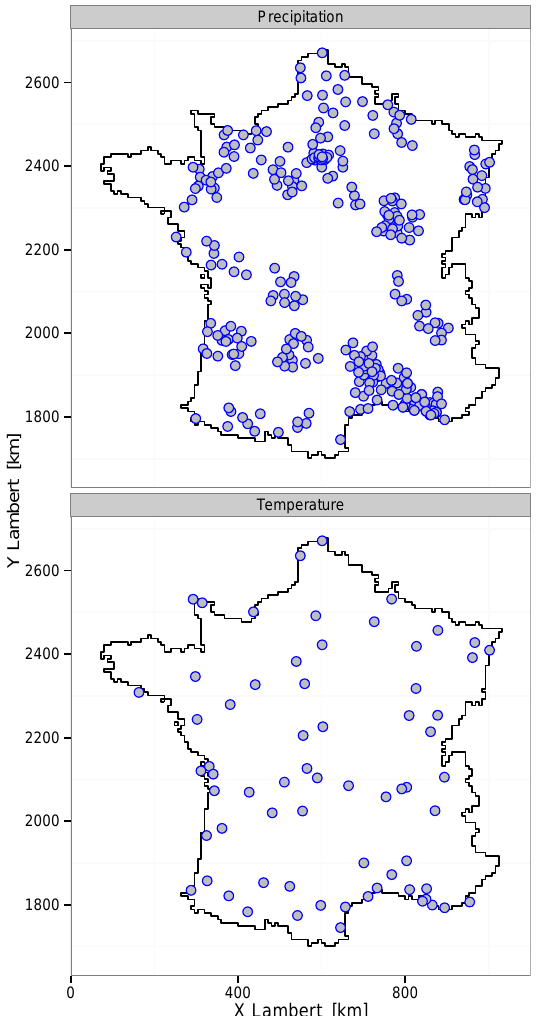
Figure 3. Spatial coverage of the available precipitation and tem- perature homogenized series produced by Météo-France during the full 1900–2000 period in